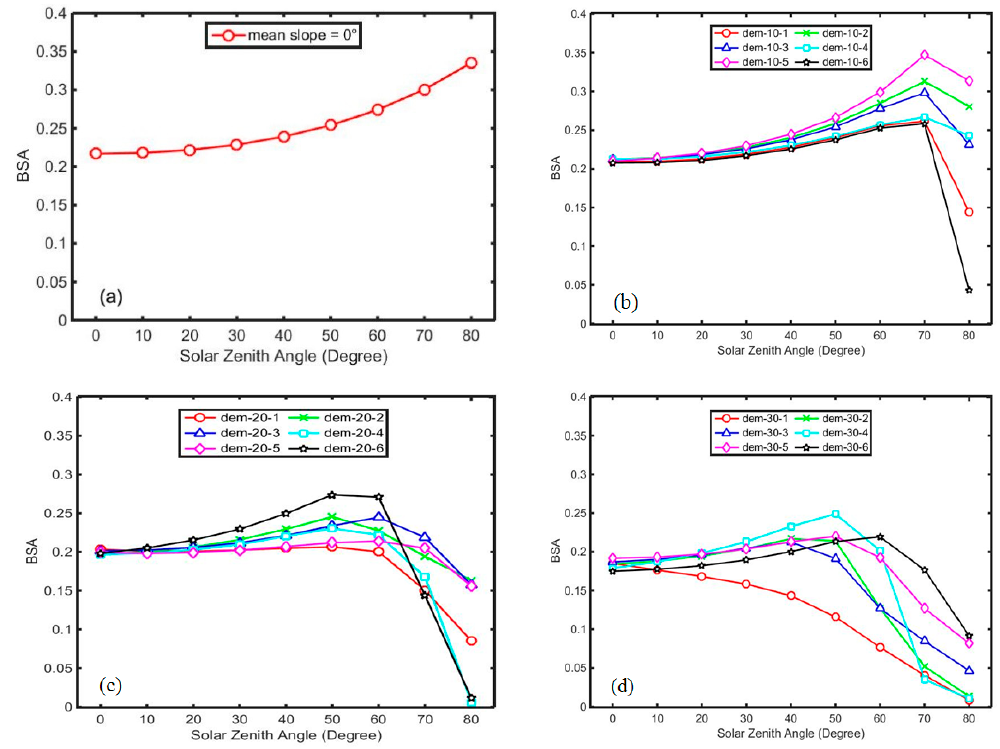
Figure 10. BSA variation with SZA for terrains with different mean slopes: ( a ) 0°; ( b ) 10°; ( c ) 20°; and ( d ) 30°. The SAA is 150°.